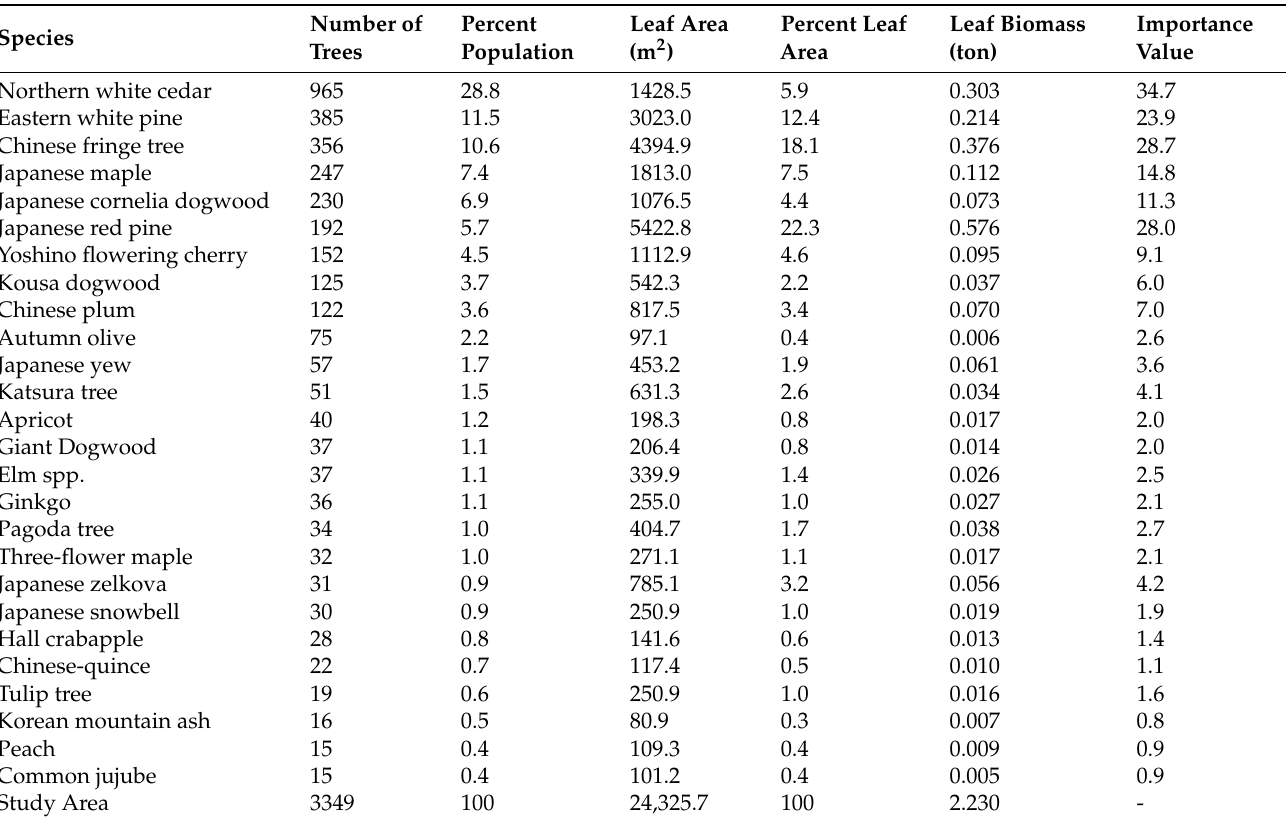
Table A1. Structure summary by species and importance values by